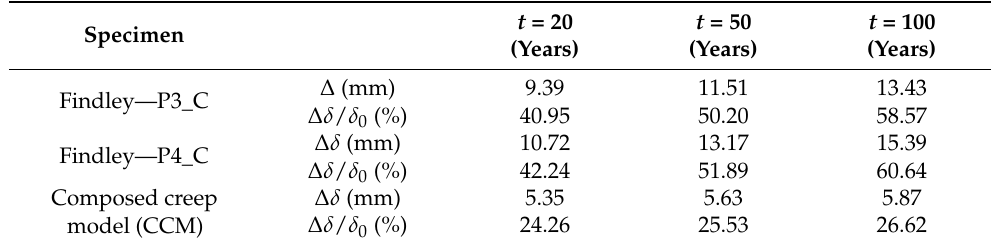
Figure 18. Long-term predictions of composed creep model versus Findley’s power law: ( a ) creep deformation and ( b ) total deformation. Table 14. Predictions of long-term creep deflections: composed creep model (CCM) and Findley’s power law.